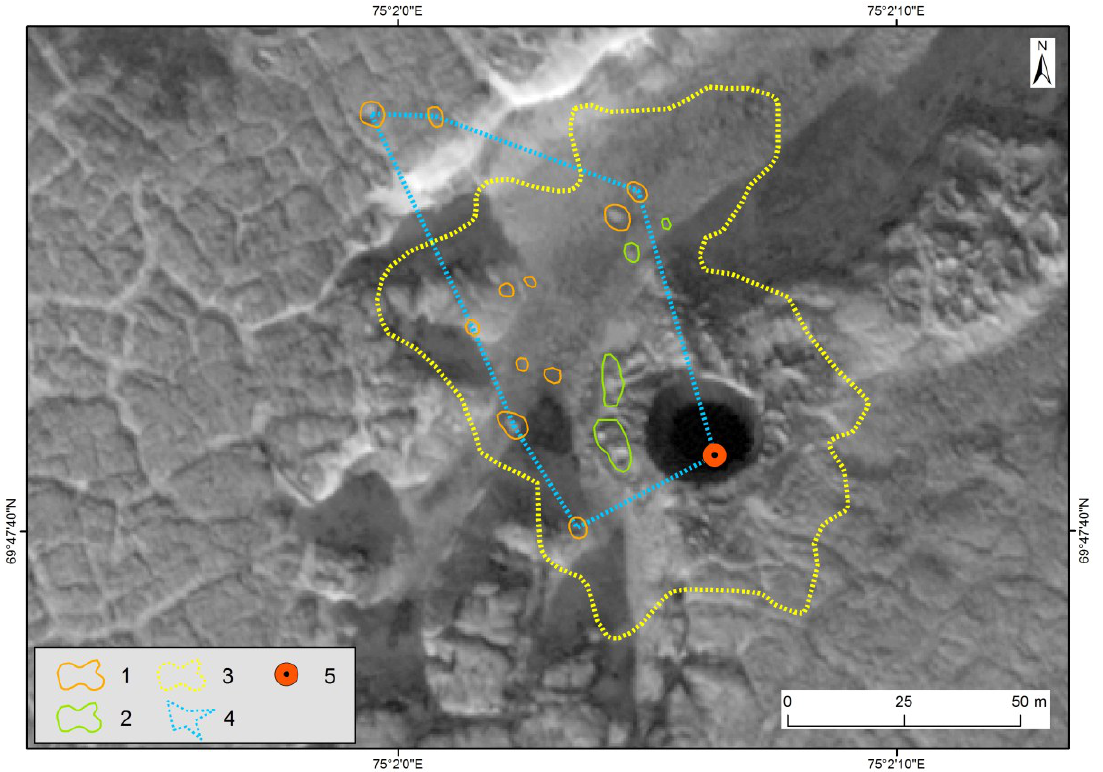
Figure 14. Location of the impact hollows and accumulative piles in the vicinity of AntGEC allocated in the satellite image of WorldView-1 as of 11 October 2014, and during the field work of 2016. Legend: 1, impact hollows; 2, agglomeration of ejected material or single piles; 3, 4, zones, allocated on the basis of both field data and RSD, 3, zone B; 4, zone A; 5, position of the AntGEC AMP. Analysis of the WorldView-1 image dated 11 October 2014 revealed positions of 11 impact hollows at a distance from 33.3 m (WSW) to 104 m (NW) from AMP (Figure 15). Most (82%) of these hollows are concentrated at a distance less then 60 m from AMP. Largest impact hollows (with area exceeding 20 m 2 ) are distributed evenly within the zone A in relation to AMP.